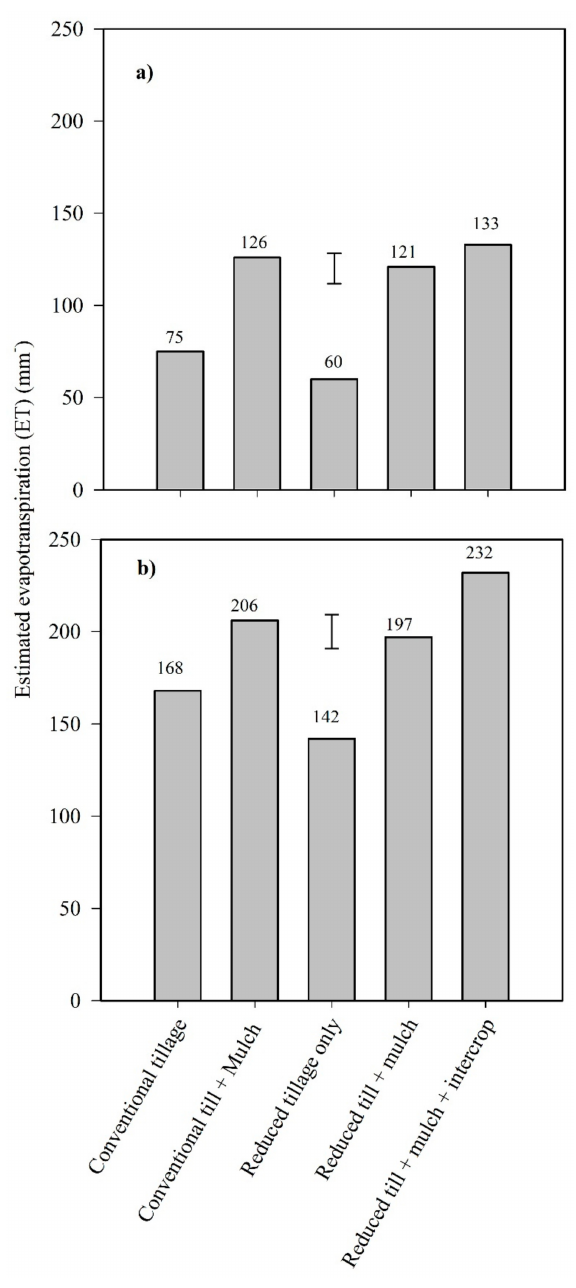
Figure 8. Estimated evapotranspiration in conventional tillage only (control), conventional tillage + mulch (partial CA1), reduced tillage only (partial CA2), reduced tillage + mulch (partial CA3) and reduced tillage + mulch + intercropping with cowpea (full CA) treatments under finger millet during 2015/16 ( a ) and 2016/17 ( b ) cropping season. Error bars represent LSD 0.05